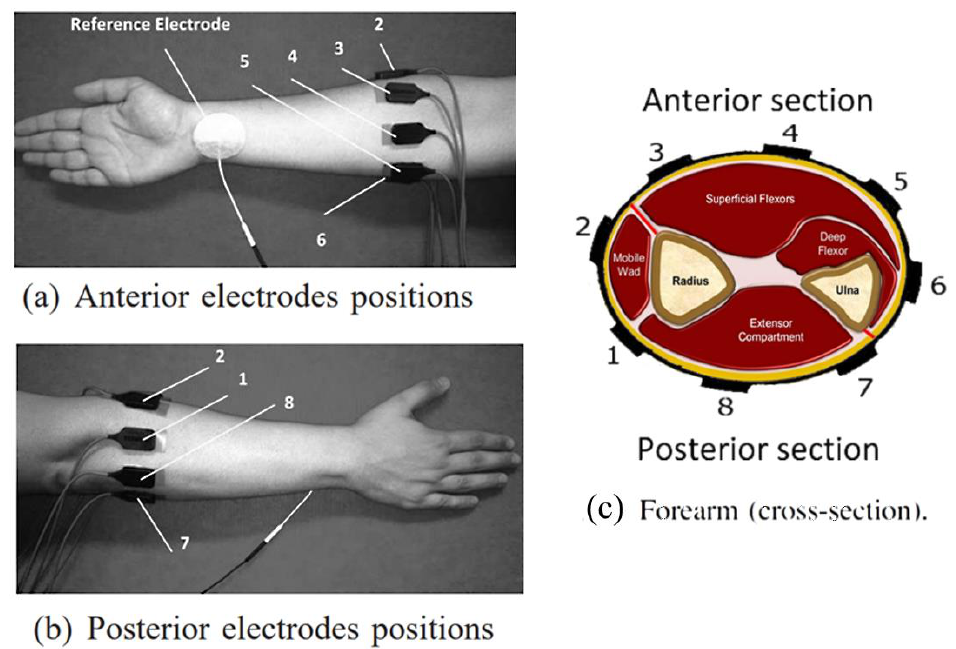
Figure 1. Electrode placement on the right forearm. ( a ) Anterior electrode positions; ( b ) posterior electrode positions; ( c ) muscle zones and electrodes placed on the cross-section of the forearm. Figures 1a,b are reprinted/adapted with permission from Ref. [32], Copyright 2012, IEEE.